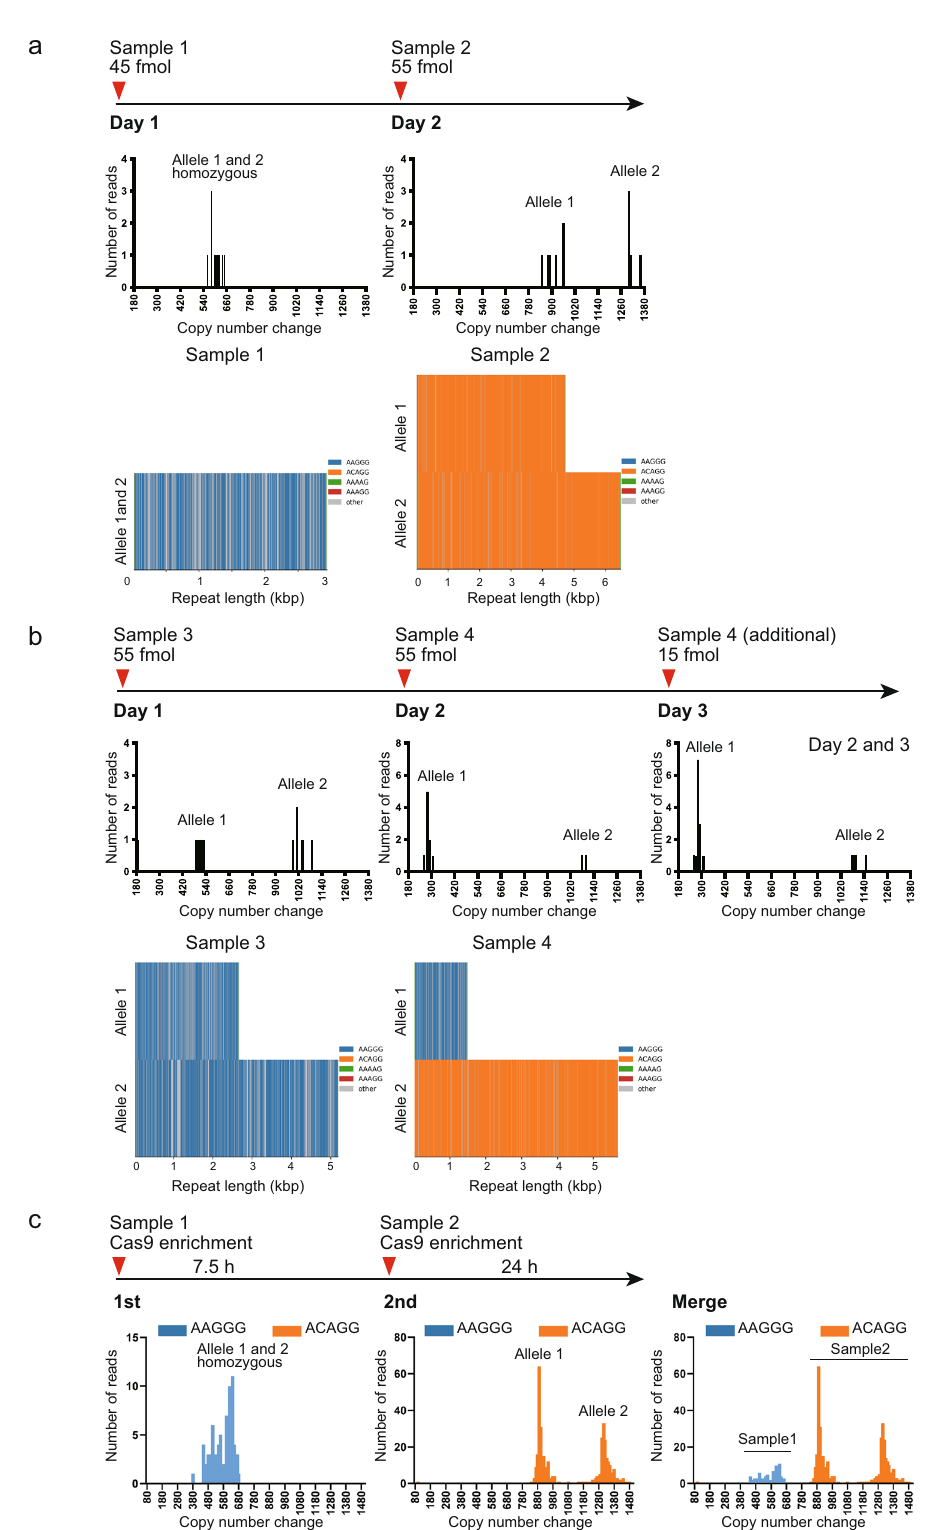
Fig. 6 Time-lag sampling. We sequenced four patients with CANVAS, three of whom (Samples 2, 3, and 4) were previously sequenced by HiFi LR-WGS using the PacBio Sequel II system (Paci fi c Biosciences, Menlo Park, CA, USA) 34 . Sample 1 was identical to Patient 9. a Time-lag sampling of Sample 1 loading 45 fmol of library on day 1 and Sample 2 loading 55 fmol on day 2 on one GridION fl ow cell detected pathogenic repeat expansions in both samples. b Time-lag sampling of Sample 3 loading 55 fmol of library on day 1 and Sample 4 loading 55 fmol on day 2 and 15 fmol on day 3 on one GridION fl ow cell detected pathogenic repeat expansions in both samples. For Sample 4, all remaining library (15 fmol) was loaded again on day 3 because the sequencing output did not reach the satisfactory level at the end of day 2. c Time-lag sampling with Cas9-mediated PCR-free enrichment libraries of Samples 1 and 2. We sequenced Samples 1 and 2 for 7.5 and 24 h, respectively. For Sample 2, there was no AAGGG repeat expansion in its sequencing output, indicating no carryover DNA from Sample